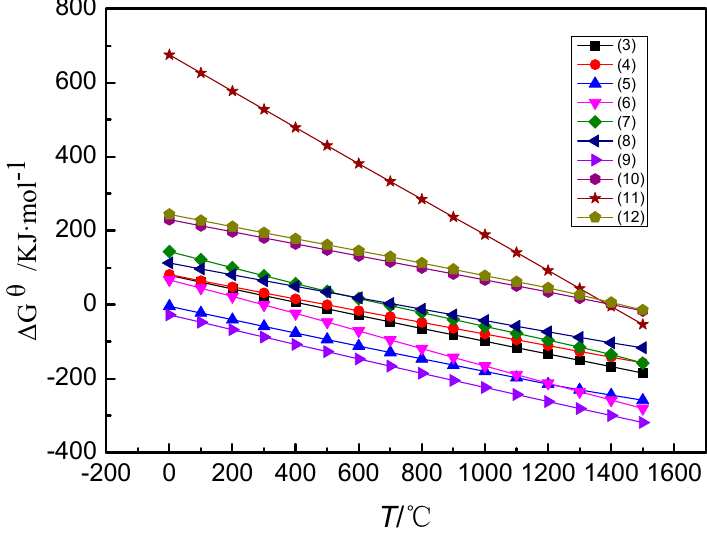
Figure 2. Temperature effects on the standard Gibbs free energy changes for Equations (3)–(12).